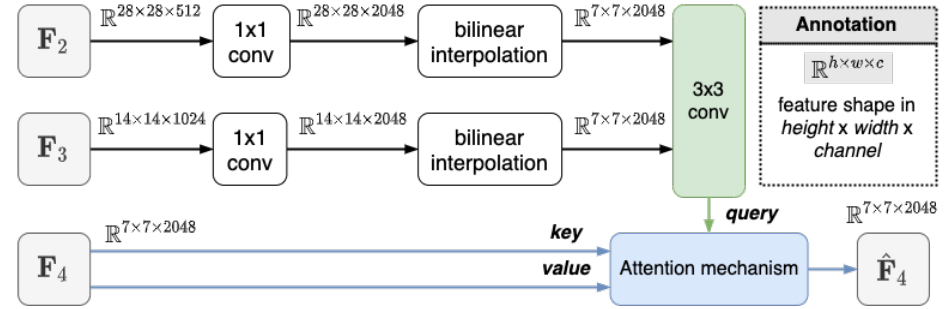
Figure 3. Diagram of Context adaptation